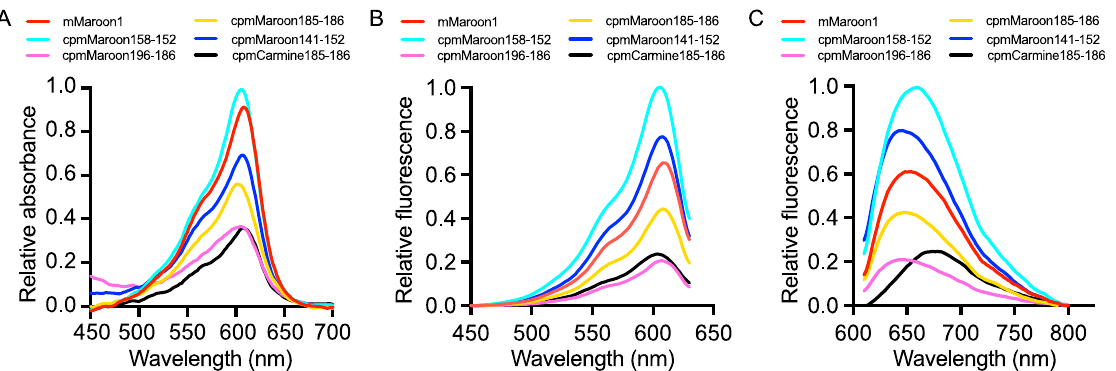
Figure 4. Absorbance, excitation, and emission spectra for circularly permuted mMaroon1 and mCarmine variants. ( A ) Absorbance spectra in order of highest to lowest intensity at 600 nm: cpmMaroon158-152 (cyan), mMaroon1 (red; included for comparison), cpmMaroon141-152 (blue), cpmMaroon185-186 (yellow), cpmCarmine185-186 (black), and cpmMaroon196-186 (magenta). ( B ) Excitation spectra labeled in the same color schedule as in panel A. ( C ) Emission spectra labeled in the same color schedule as in panel A. Table 1. Properties of circularly permuted mMaroon1 and mCarmine variants.